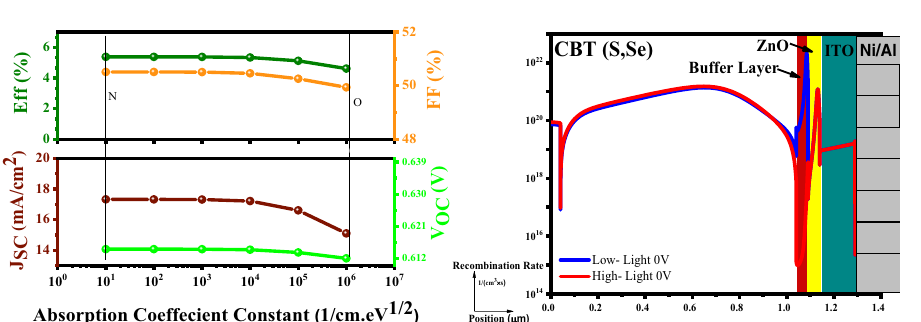
Figure 12. Variation of the solar cell parameters of the CBT (S, Se) solar cells with different the Absorption Coefficient Constant (1/cm eV 1/2 ) of In 2 S 3